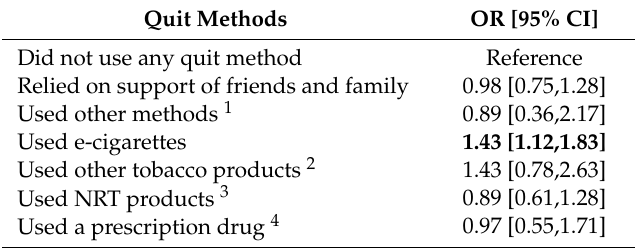
Table 3. Adjusted odds ratios (OR) and 95% confidence intervals (CI) for being a past-year former smoker, according to single quit method and other